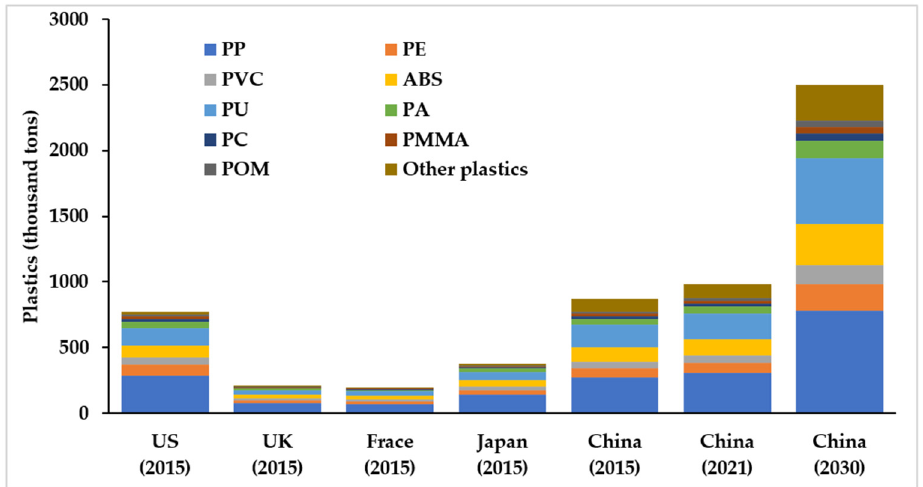
Figure 5. The potential of recyclable plastics from EoL passenger vehicles in multiple countries.